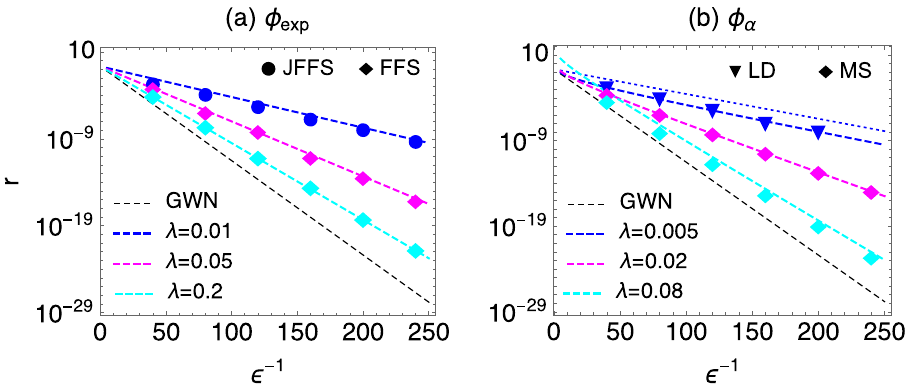
Figure 3. Comparison of the theoretical predictions (lines) for the escape rate r and results from numerical simulations. We have employed forward-flux sampling (FFS), jumpy forward-flux sampling (JFFS), direct Langevin simulations (LD), and a numerical solution of the Master equation (MS). The potential is V ( q ) = q 4 / 4 − q 2 / 2 , D = 1 , and we have set the rescaled noise intensity (cid:31) a 2 of the non-Gaussian component √ (cid:31) , which leaves (cid:31) as the only free parameter. Dashed black line: escape rates for purely also to unity, i.e., a = 1 / α = 0.8 , leading to jump instantons for (cid:31) = 0.005 and (cid:31) = 0.02 ; the predicted jump prefactor (20) clearly gives a better description of the data than the Eyring-Kramers prefactor (dotted line for (cid:31) = 0.005 ). In both ( a ) and ( b ) the largest escape rates are achieved for (cid:31) → 0 , see also Fig.